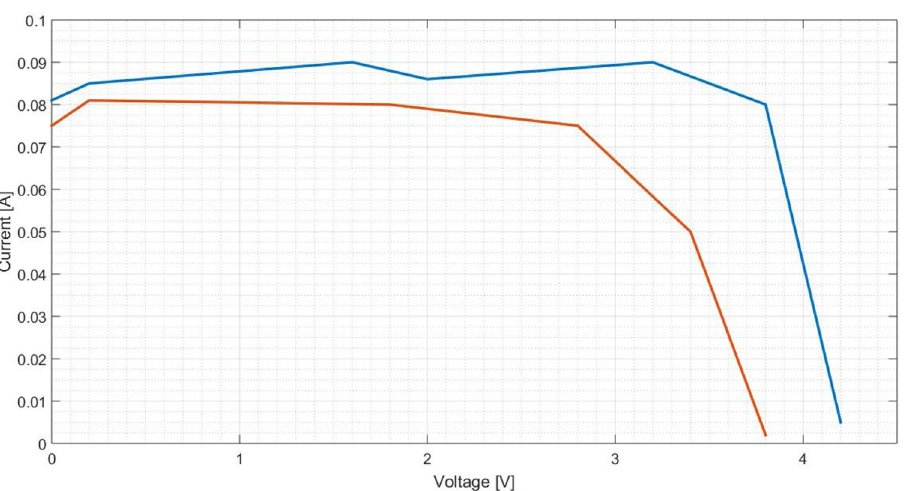
Figure 29. Comparison between I(V) curves of painted aluminium plate (Blue: Day 0; Red: Day 30).